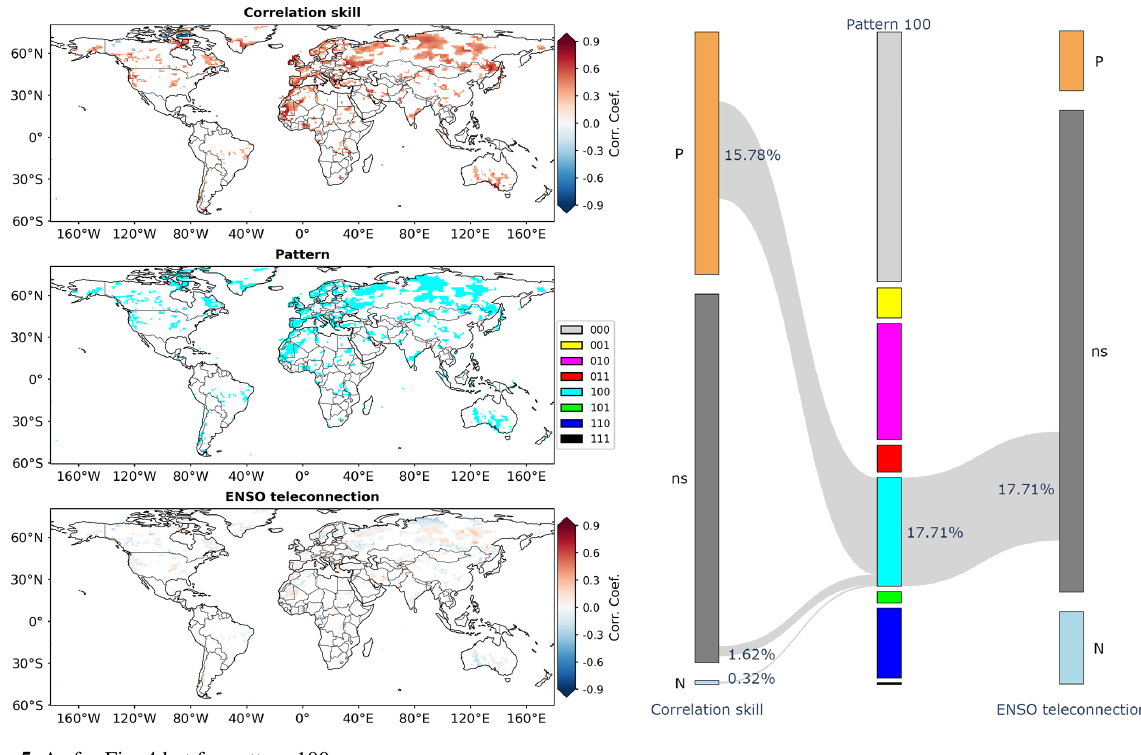
Figure 5. As for Fig. 4 but for pattern 100.